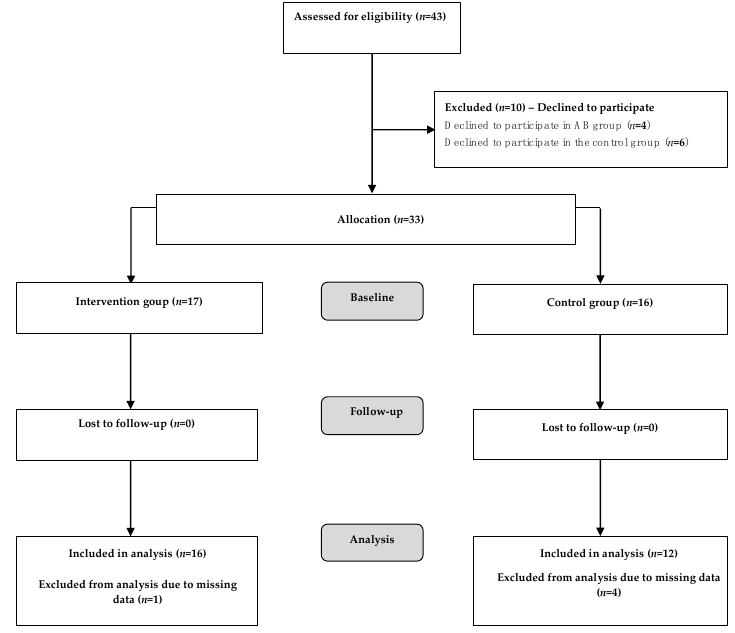
Figure 1. Flowchart of participants through each stage of the study .